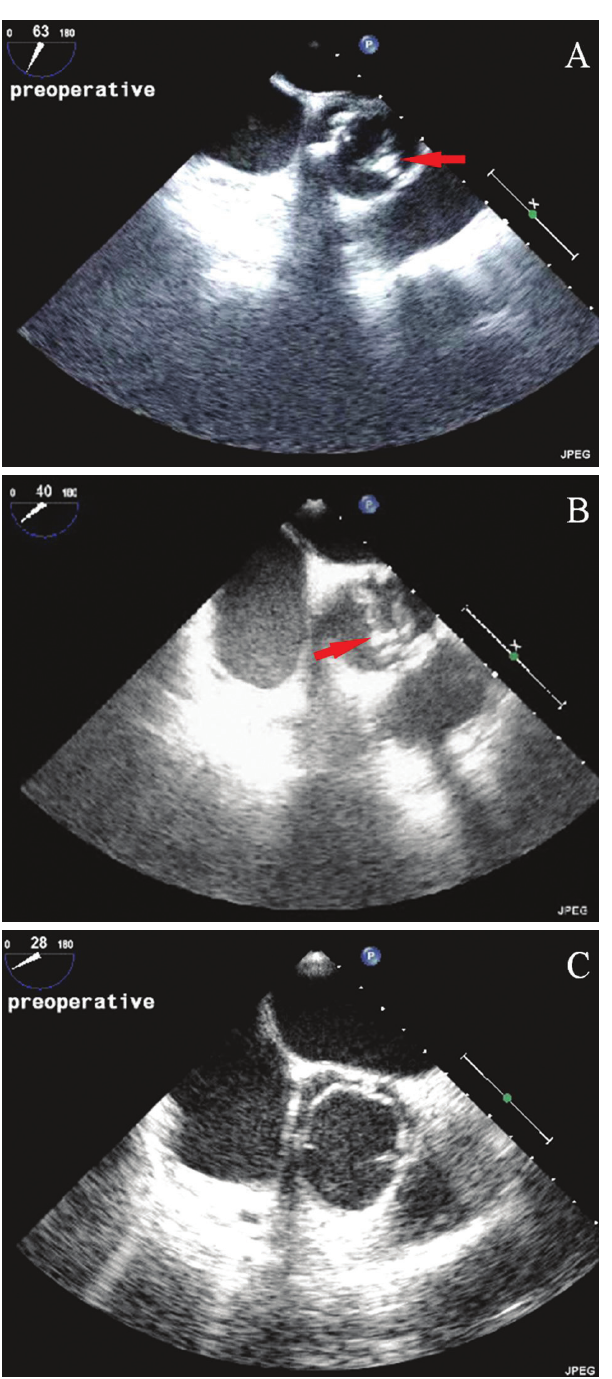
Figure 1 - Short axis views from intraoperative transesophageal echocar- diography. (A) Type A bicuspid aortic valve with two commissures at 2 and 8 o’clock and a raphe (arrow) at the 5 o’clock position. The anterior leaflet and the raphe are calcified. (B) Type B bicuspid aortic valve with two com- missures at 5 and 11 o’clock and a raphe (arrow) at the 7-8 o’clock position. Both leaflets and the raphe are calcified. (C) Type C bicuspid aortic valve with two commissures at the 3-4 and 9 o’clock positions with no raphe. The leaflets were free of calcification.